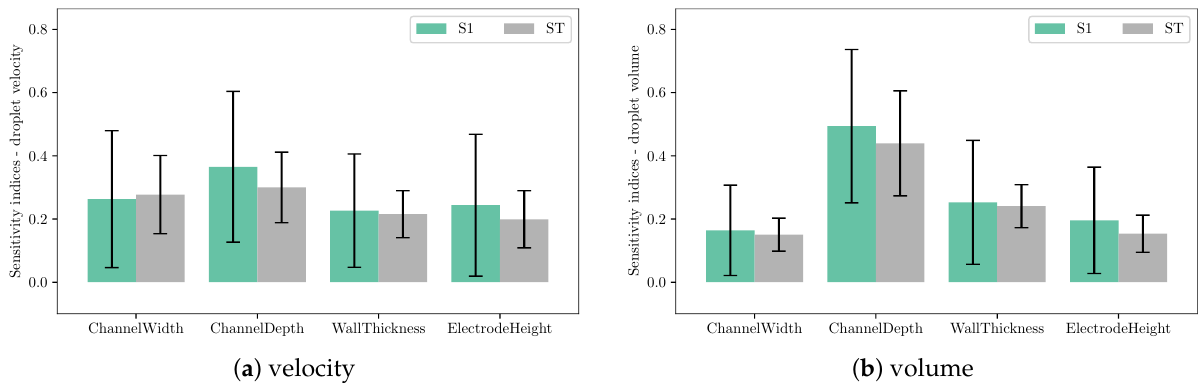
Figure 24. First order ( S 1 ) and total sensitivity ( S T ) indices of ( a ) droplet velocity and ( b ) volume to channel design parameters. The error bar indicates 95% confidence